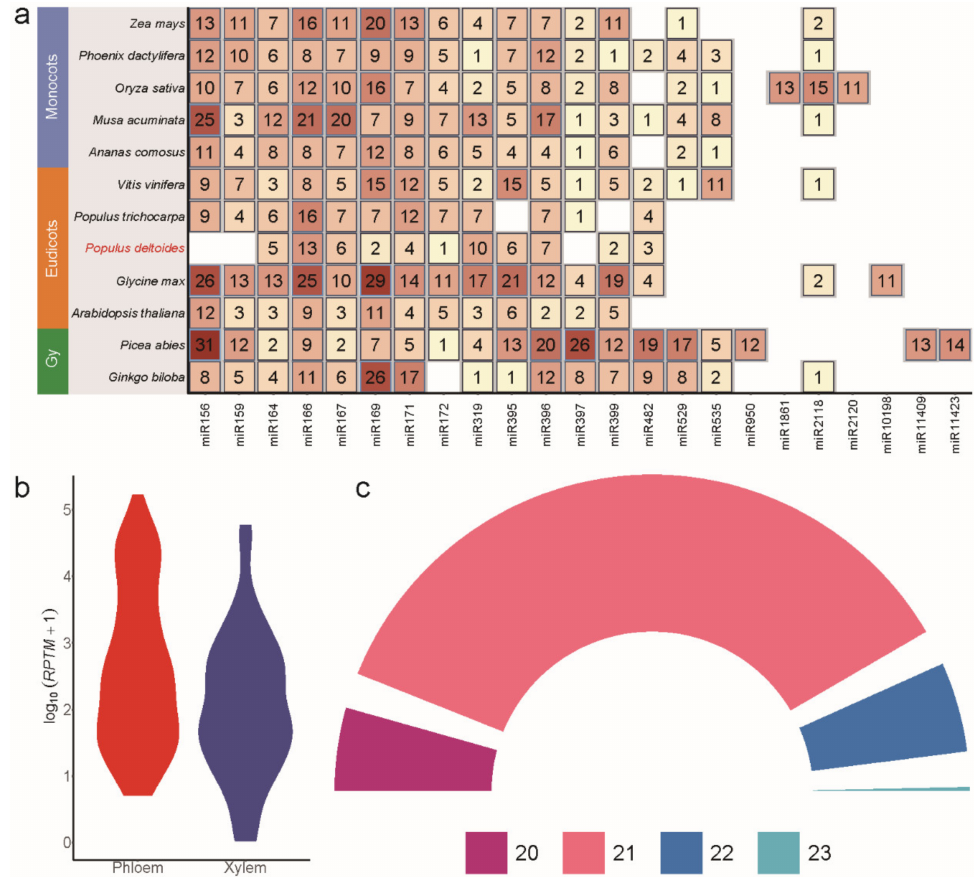
Figure 1. The miRNAs identified in the phloem and developing xylem of P. deltoides in this study. ( a ) Total numbers of known miRNA members in 12 plants. Only families with more than 10